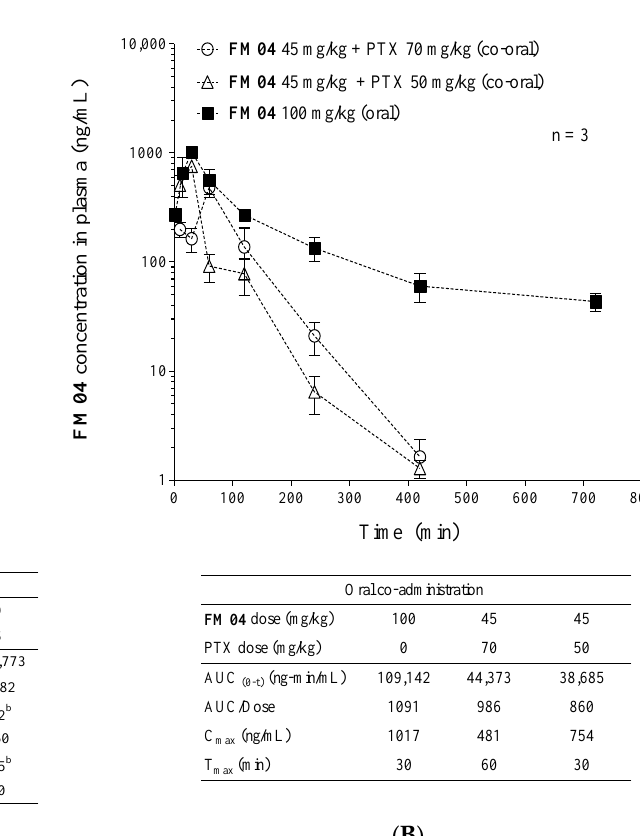
Figure 6. FM04 increased oral bioavailability of PTX. Pharmacokinetics (PK) study of PTX or FM04 after their oral co-administration. ( A ) oral PTX PK profile under the effect of FM04 administration. PTX (20 or 70 mg/kg) was orally co-administered with FM04 (0, 22 or 45 mg/kg) to mice, plasma was collected at 30, 60, 120, 240 and 420 min, respectively. The concentration of PTX at each time point was determined by UPLC-MS/MS. a Fold change of AUC/Dose or C max was relative to the 20 mg/kg PTX alone. b Fold change of AUC/Dose or C max was relative to the 70 mg/kg PTX alone. The values were presented as mean ± standard error of mean (n = 3 mice for each time point). ( B ) oral FM04 PK profile under the effect of PTX administration. FM04 (45 or 100 mg/kg) was orally co-administered with PTX (0, 50 or 70 mg/kg) to mice, plasma was collected at 30, 60, 120, 240 and 420 min, respectively. The concentration FM04 at each time point was determined by UPLC-MS/MS Pharmacokinetic parameter AUC was calculated by the pharmacokinetic software-Summit ® PK solutions 2.0 (Summit Research Service, Ashland, Wilmington, DE, USA).